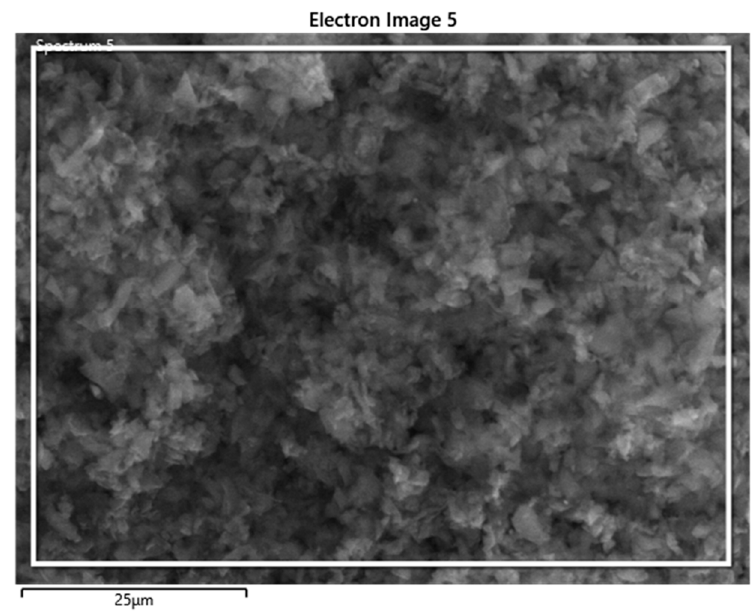
Figure 2. FESEM overview of BC at different magnifications.